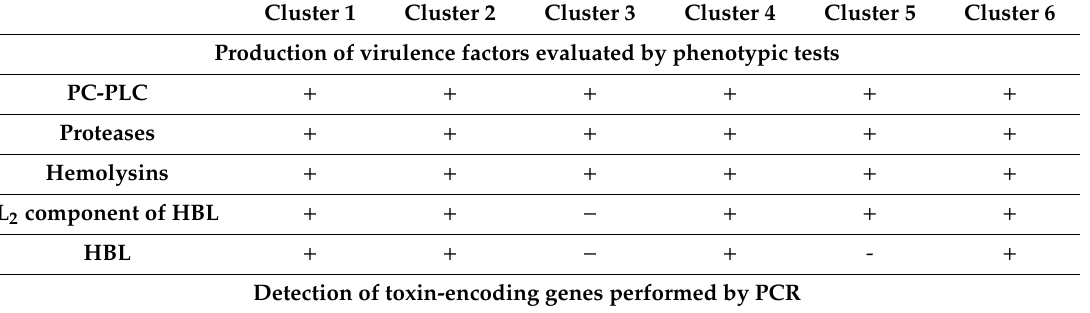
Table 2. Production of PC-PLC, proteases, hemolysins, L 2 component of HBL, and HBL by each clusters evaluated by phenotypic tests and detection of toxin-encoding genes in bacterial genome performed by